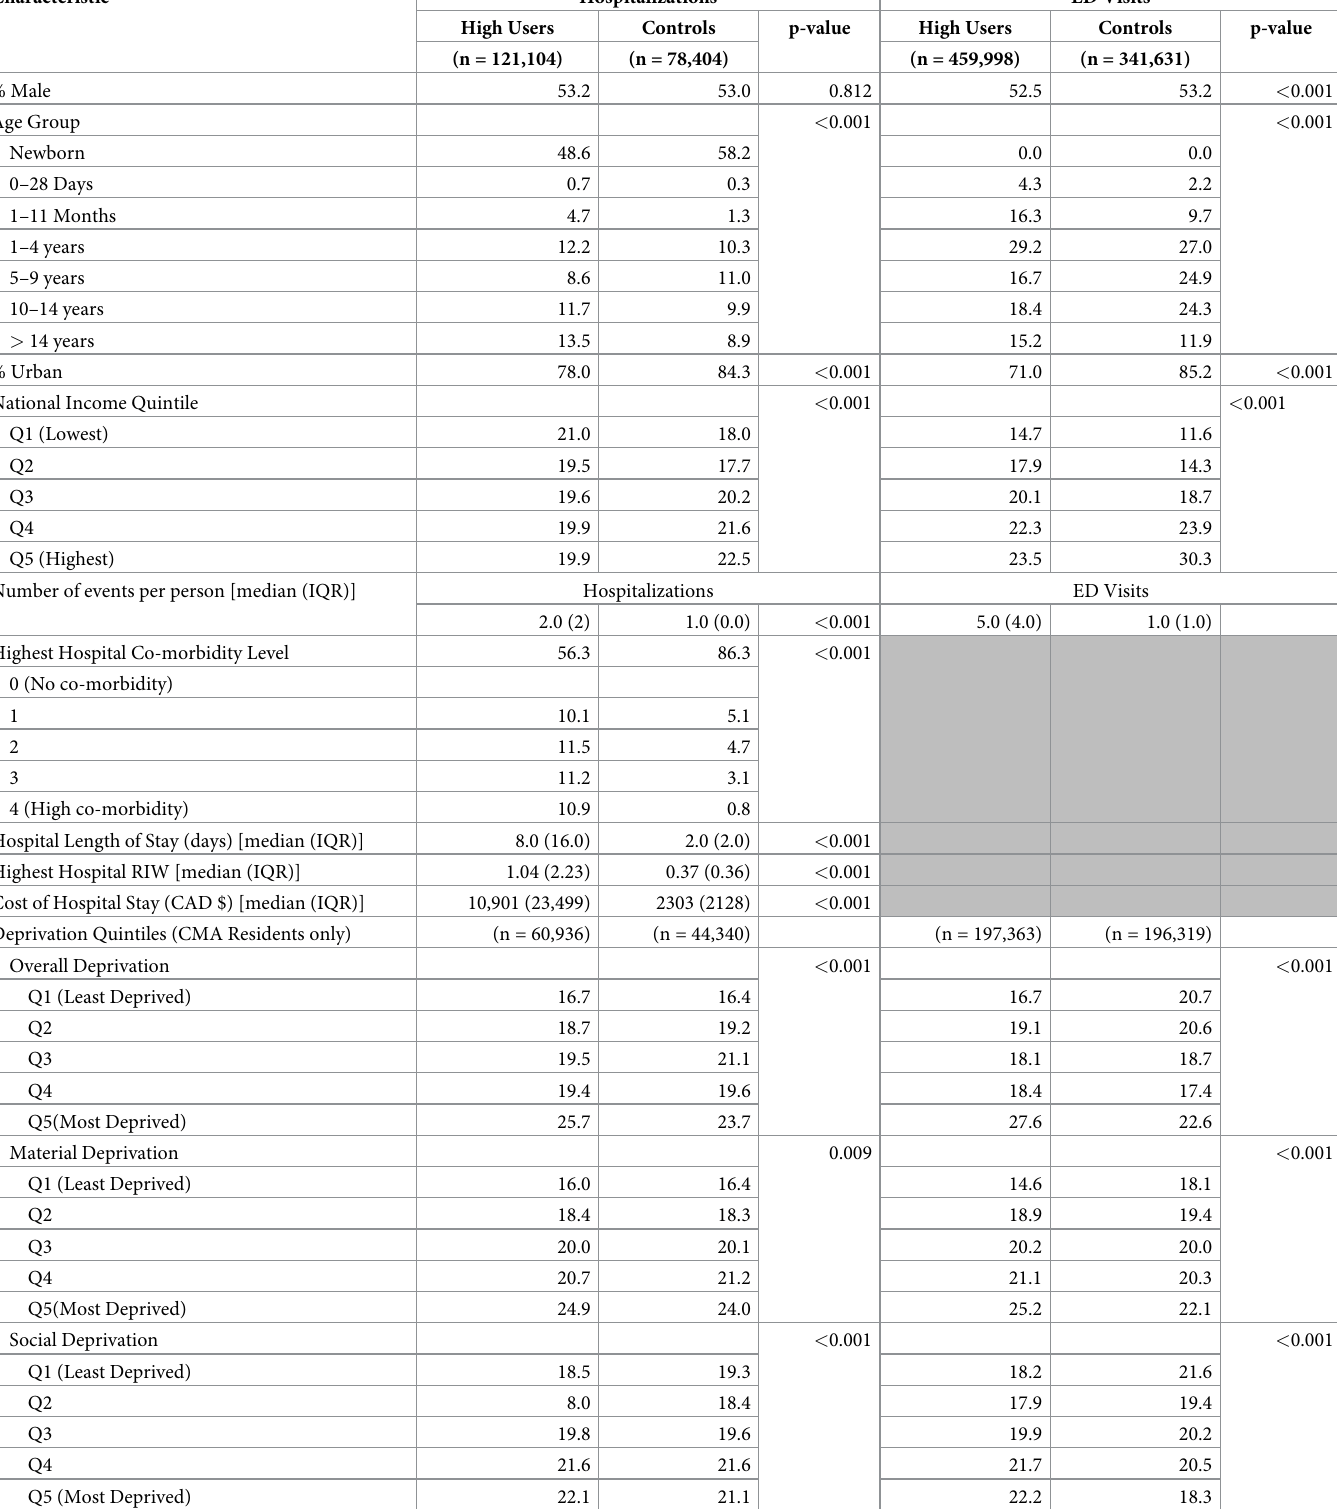
Table 1. Sociodemographic and morbidity characteristics of hospital and ED high